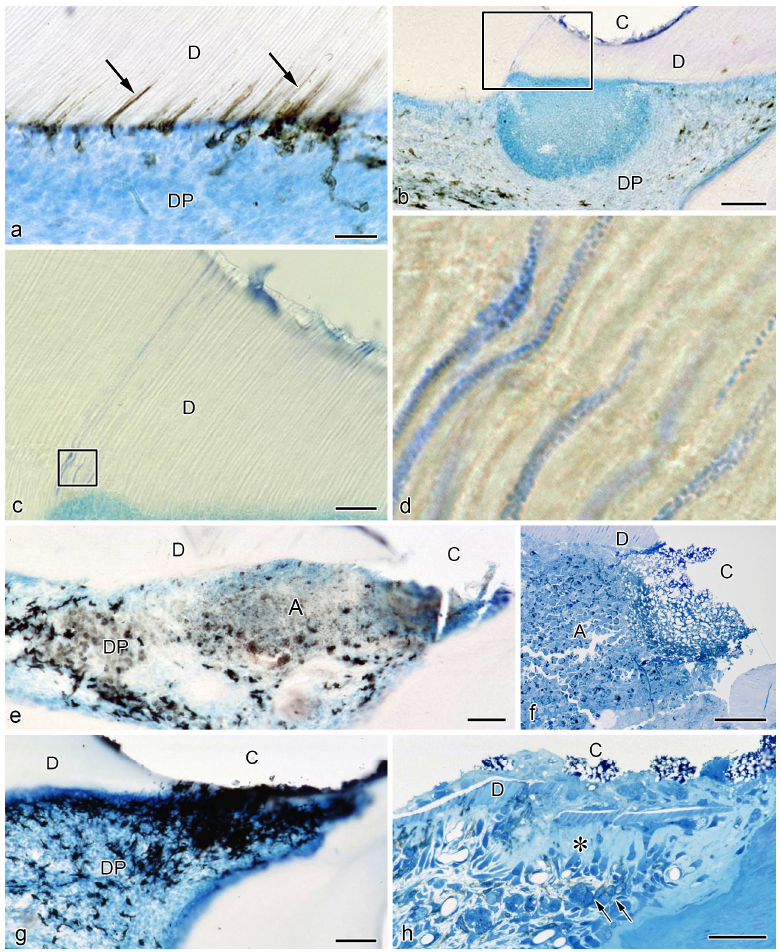
Figure 5. Responses of DCs to bacterial infection in the dental pulp. ( a – d ) Cavity preparation injury model using laser ablation (cited from Suzuki et al. [46], with permission from Springer Nature and Sato et al. [48], with permission from Archives of Histology and Cytology). ( e – h ) Cavity prepara- tion and pulp capping model with α TCP cementum or α TCP cementum containing a 3Mix drug combination. ( a – h ) Immunohistochemistry with OX6 antibody. ( f , h ) Semithin sections. ( a ) OX6 + cells extend their processes deep into the dentinal tubules (arrows). ( b ) Laser ablation induces the infiltration of PMLs to form an abscess lesion in the dental pulp in most samples of the nontreated group from days 3 to 5 after the operation. Scattered OX6 + cells are observed at a distance from the abscess formation. ( c , d ) Higher magnification of the boxes in ( b ) and ( c ). The penetration of masses of oral bacteria can be identified in the dentinal tubules beneath the untreated cavity. ( e ) From day teeth covered with α TCP cementum, particularly in the mesial half of the coronal pulp. ( f ) Neu- trophil accumulation is observed at the exposure area covered with α TCP cementum. OX6 + cells